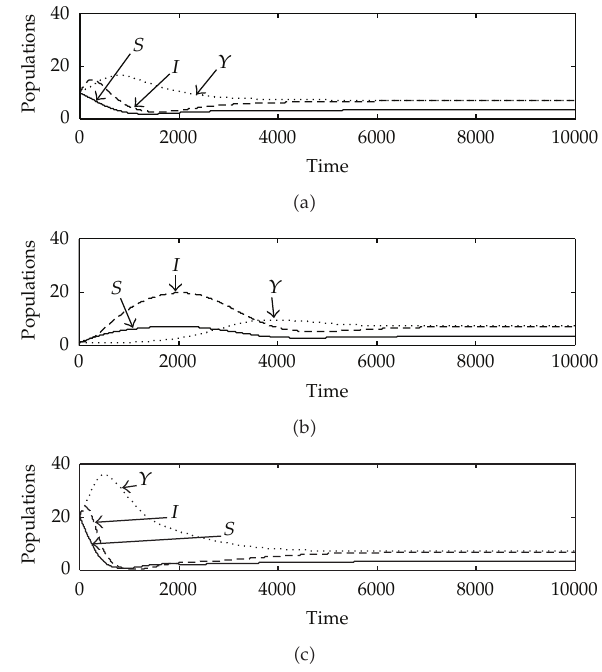
Figure 2: Time series for the point attractor in Figure 1. (cid:5) a (cid:6) The trajectories starting at (cid:5) 10 , 10 , 10 (cid:6) . (cid:5) b (cid:6) The trajectories starting at (cid:5) 1 , 1 , 1 (cid:6) . (cid:5) c (cid:6) The trajectories starting at (cid:5) 20 , 20 , 20 (cid:6)